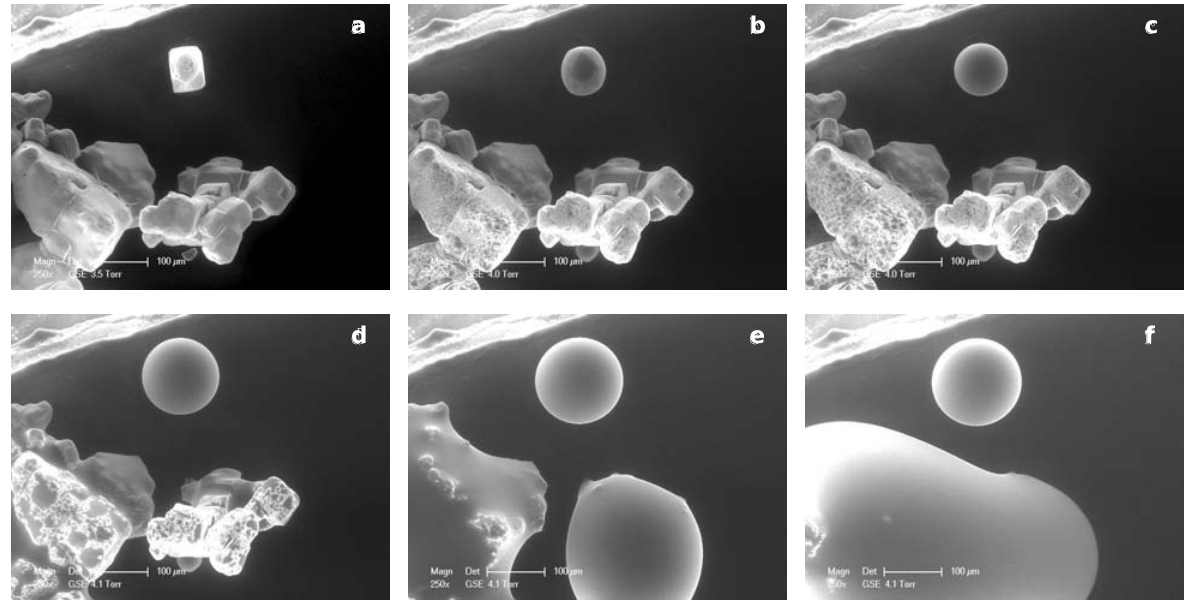
Fig. 5 Time sequence of ESEM images of the dissolution of NaCl at RH > DRH (a to f); size bar is 100 µ m in all